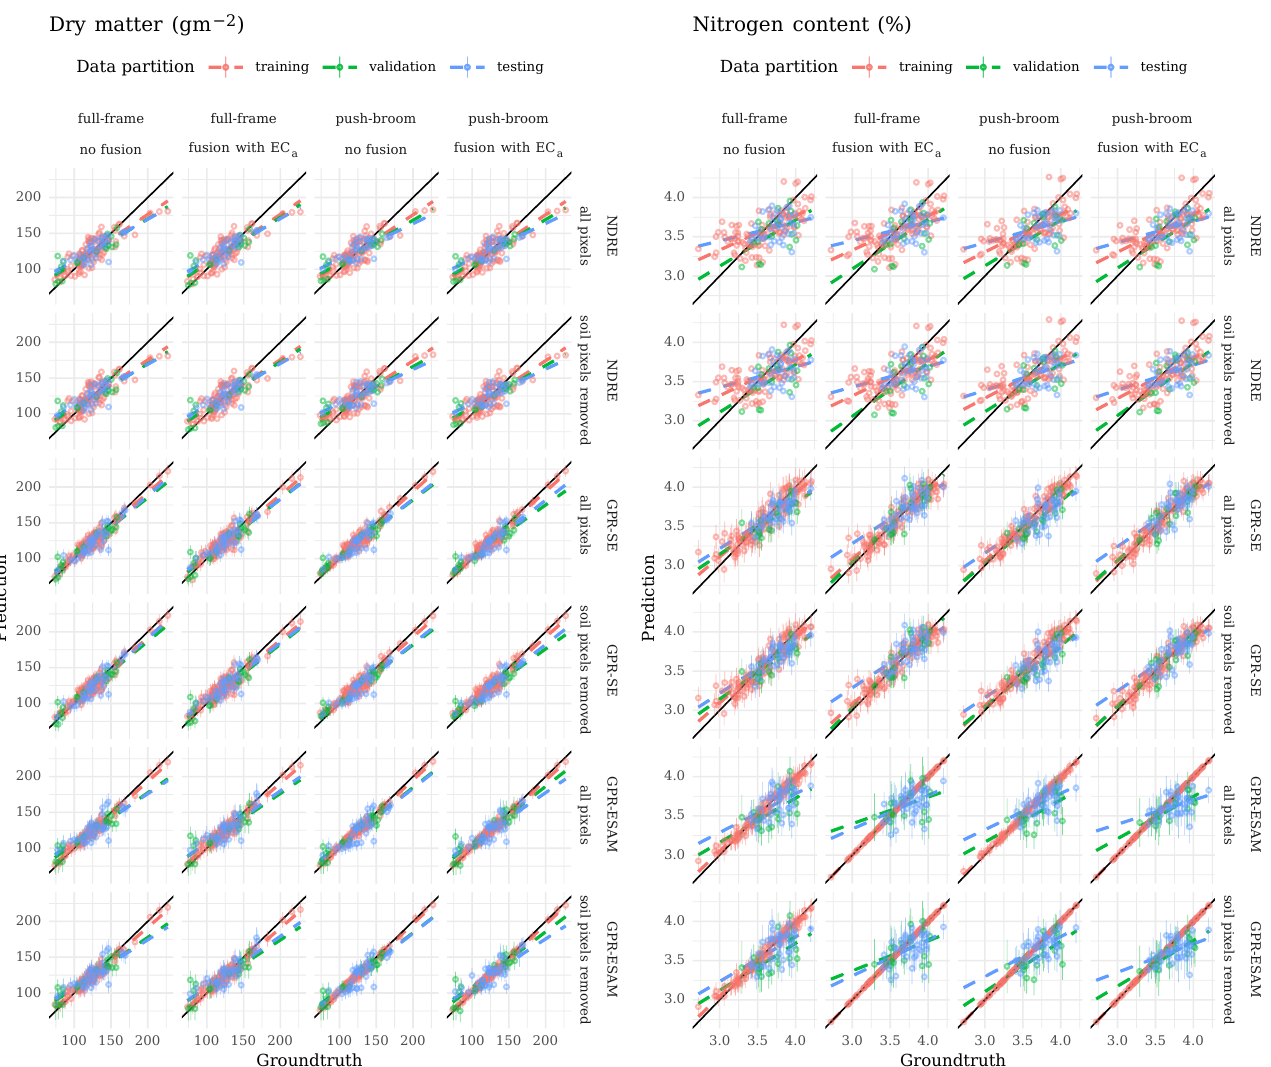
Figure 4. Dry matter and nitrogen content predictions according to the model and dataset. The in- dividual rows of plots correspond to the three predictive model families either trained to complete hyperspectral imagery or to spectra derived after the removal of soil pixels. The choice of model has a strong effect on the obtained patterns as opposed to the effect of imagery pre-processing. The columns within each of the two panels compare the performance of the two hyperspectral cameras. Choosing one over another mostly affects the NDRE predictions. Moreover, the limited effect of data fusion with apparent soil electrical conductivity measurements is depicted. The predictions are displayed relative to the 1:1 line, and those generated from Gaussian process regression models are augmented with error bars corresponding to prediction uncertainty. The patterns are shown separately for the three data partitions employed in modeling. The dashed lines are the respective linear regression fits. EC a —apparent soil electrical conductivity, NDRE—normalized difference red edge index model, GPR-SE—Gaussian process regression model with the squared exponential covariance function, GPR-ESAM—Gaussian process regression model with the spectral angle mapper covariance